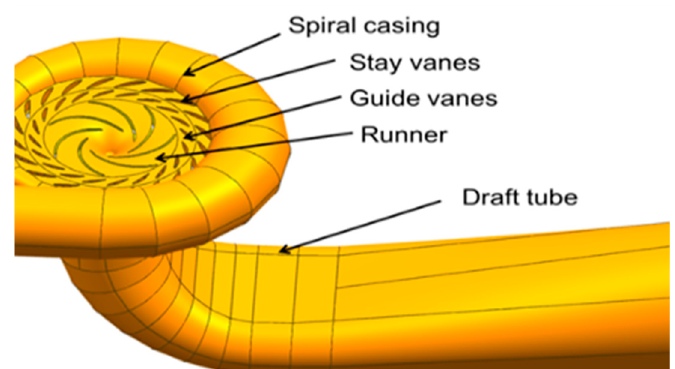
Figure 1. Hydraulic domain of the prototype pump turbine.